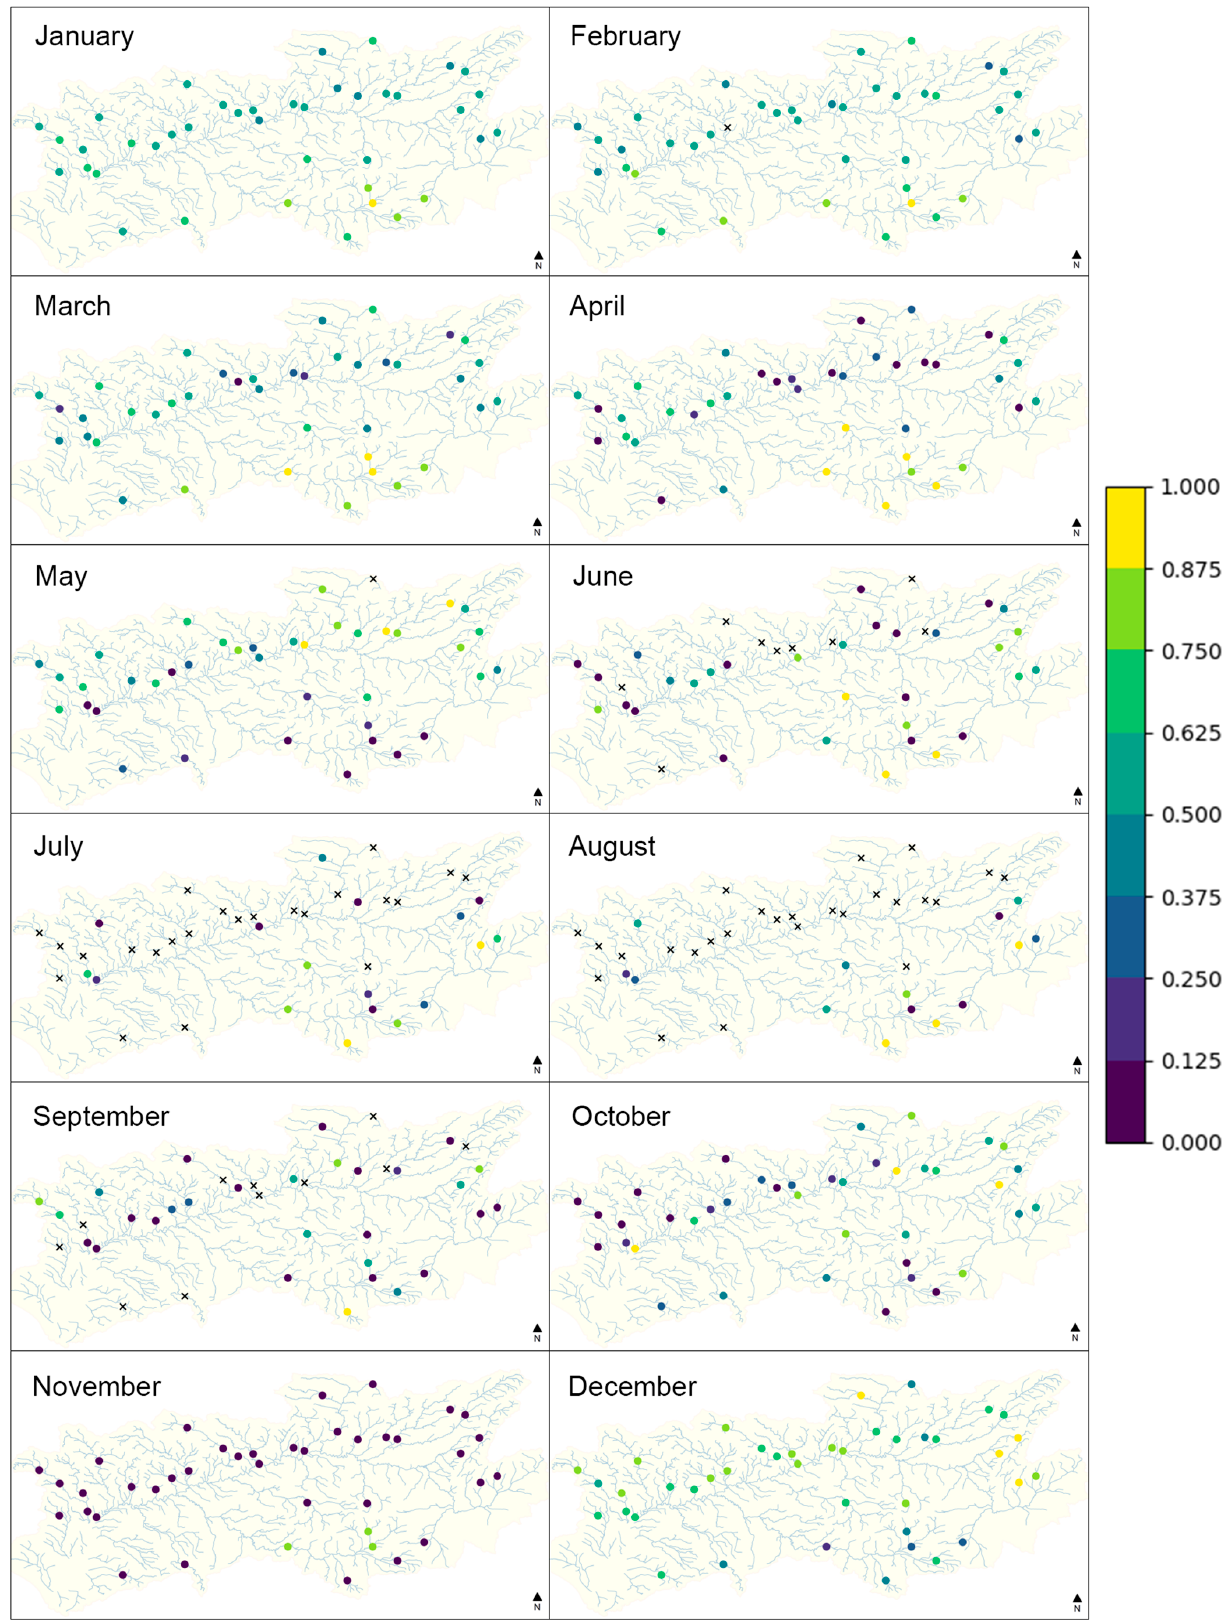
Figure 10. PC-2 loadings for the monthly series. Crossed stations indicate insufficient data for that monthly analysis.